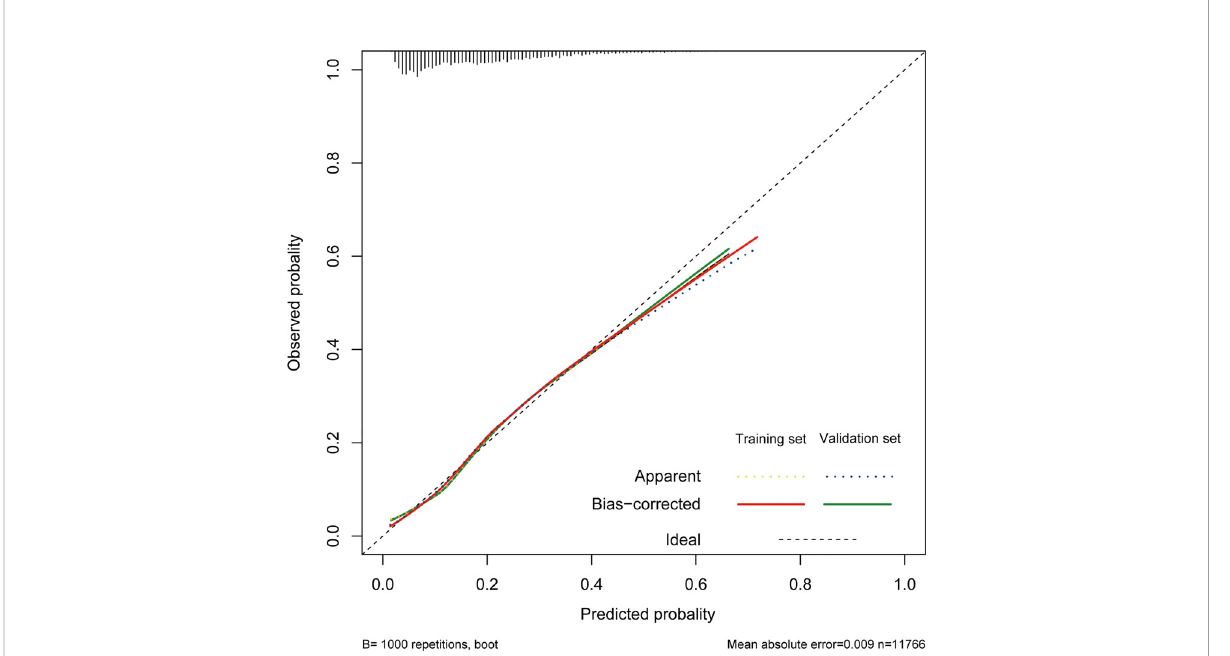
FIGURE 5 Calibration of the nomogram in the training cohort and validation cohort. The dotted line represents the ideal match between the nomogram- predicted survival (X-axis) and actual survival